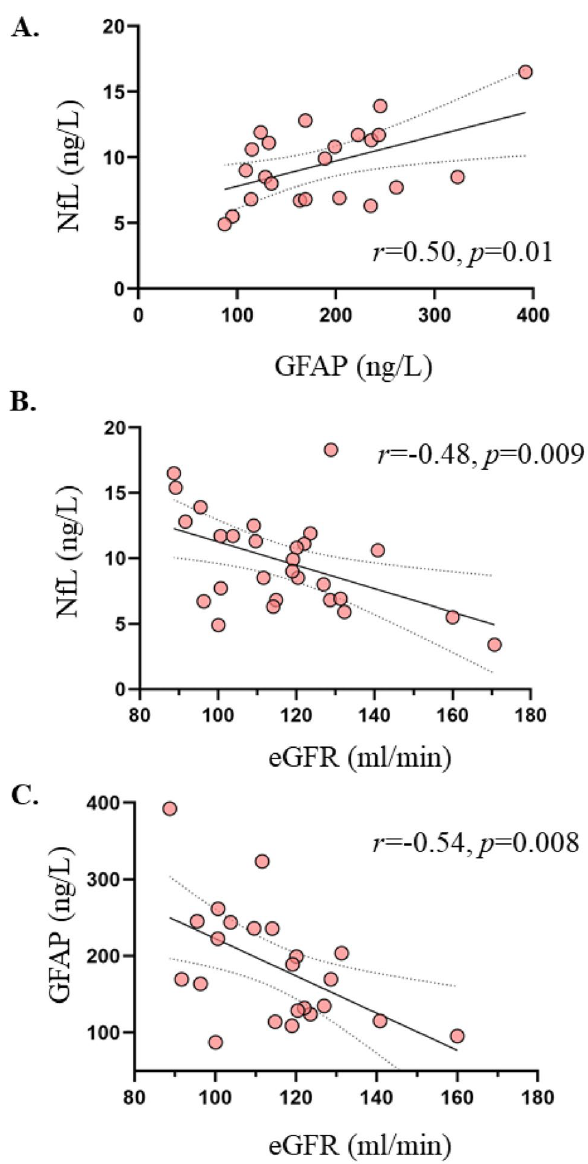
Figure 3. 6-months after bariatric surgery circulating NfL and GFAP levels were directly related to each other ( A ), and correlated inversely with total eGFR ( B , C ). GFAP glial fibrillary acidic protein, NfL neurofilament light chain, eGFR estimated glomerular filtration